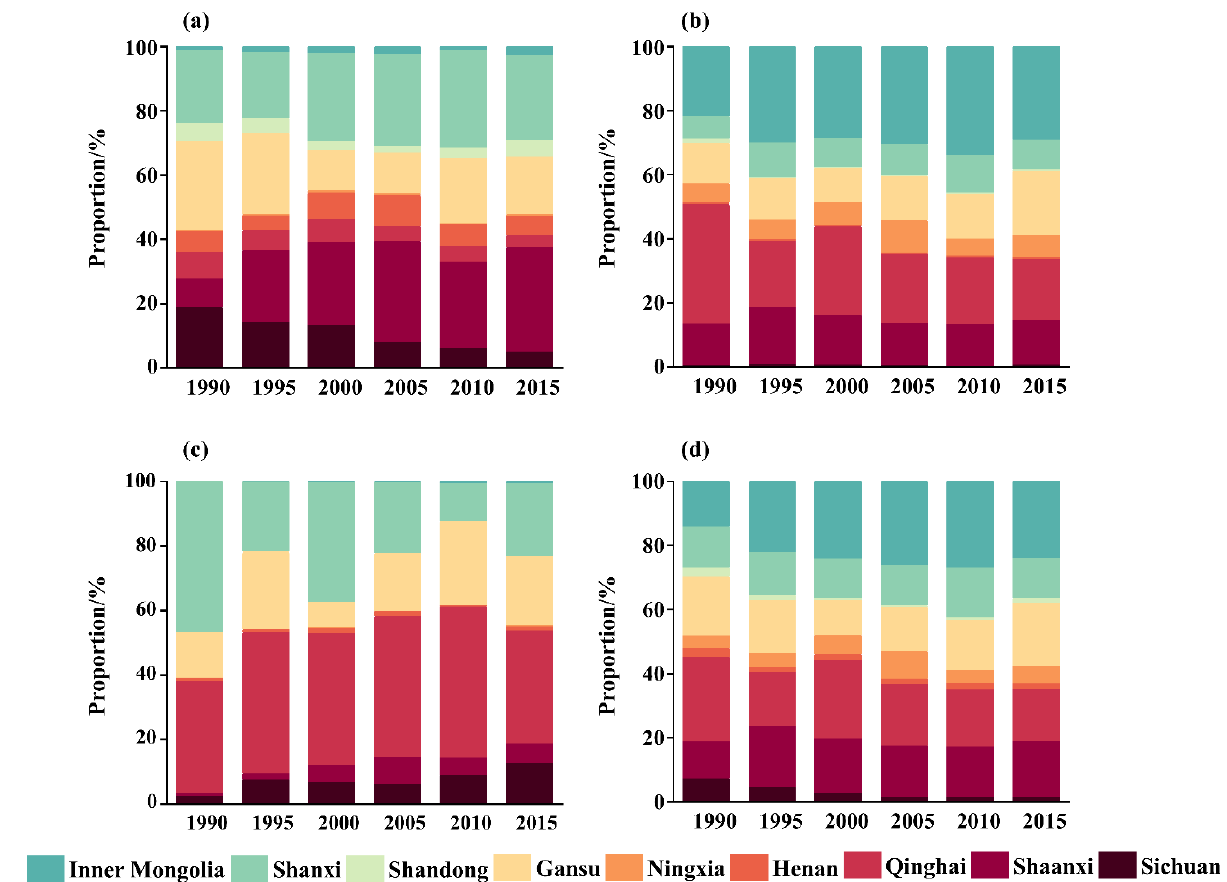
Figure 3. The temporal variation in ( d ) ERS and three subcategories(( a ) FRS, ( b ) GRS, ( c ) SRS) in different provinces of the YRB.